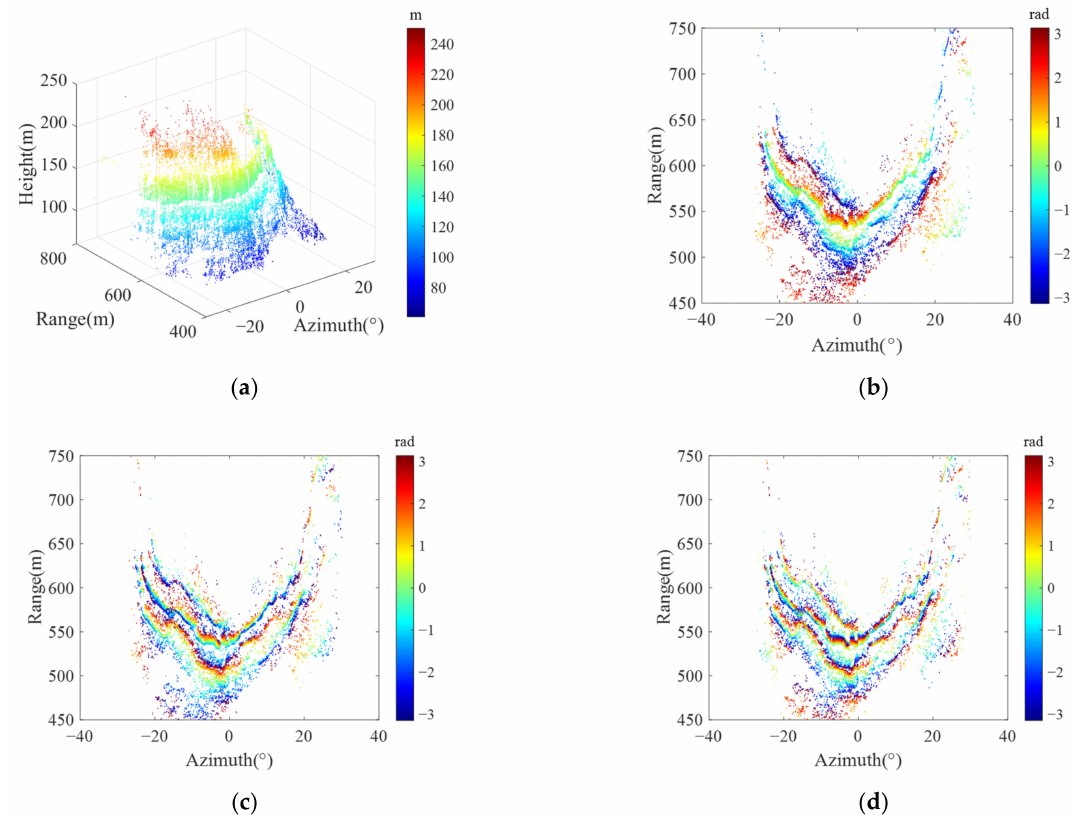
Figure 5. Simulated topography and interferograms of different baselines. ( a ) Simulated topography,